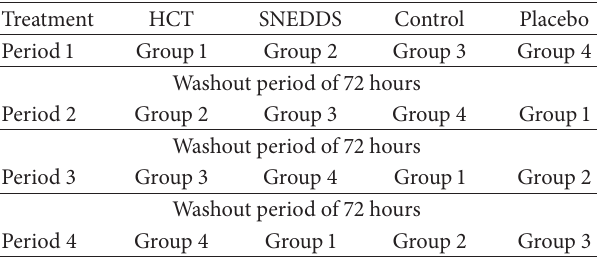
Table 5: Oral administration of pure HCT and optimized SNEDDS formulation F2 compared to control and placebo in Wistar rats.